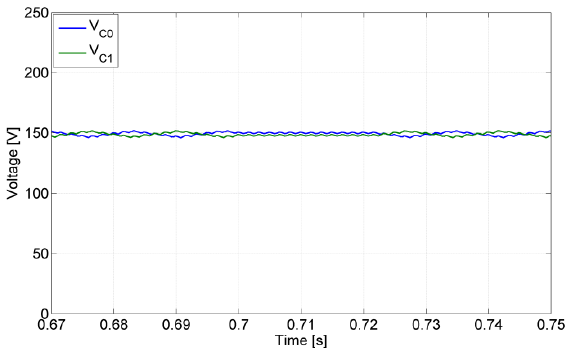
Figure 15. Voltage capacitors obtained from the simulation test with the converter operating in normal mode until t = 0.7 s and after that with a short-circuit fault in the semiconductor S 24 . Fault-tolerant mode after t = 0.73 s.